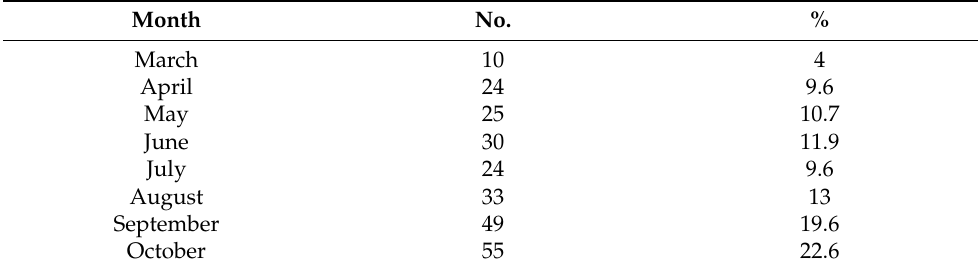
Table 1. Prevalence of deaths according to studied months.